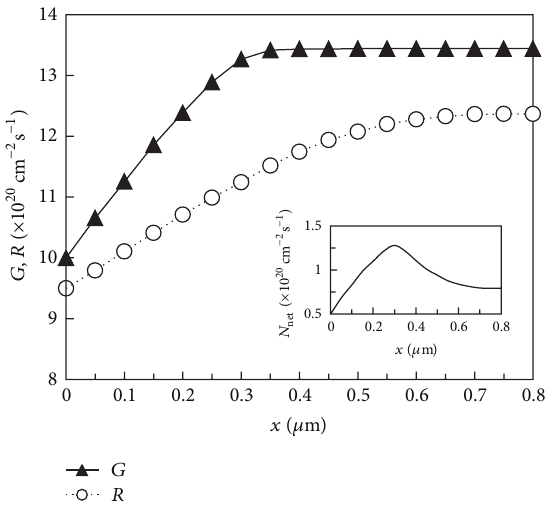
Figure 6: Light soaking effect for solar cells with different i-layer